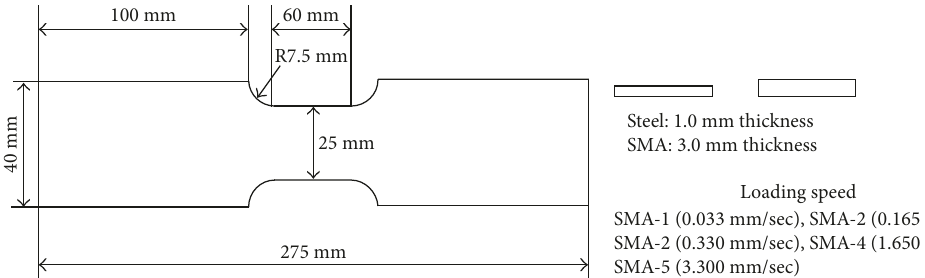
Figure 14: Specimens for the ASTM standard material tests.